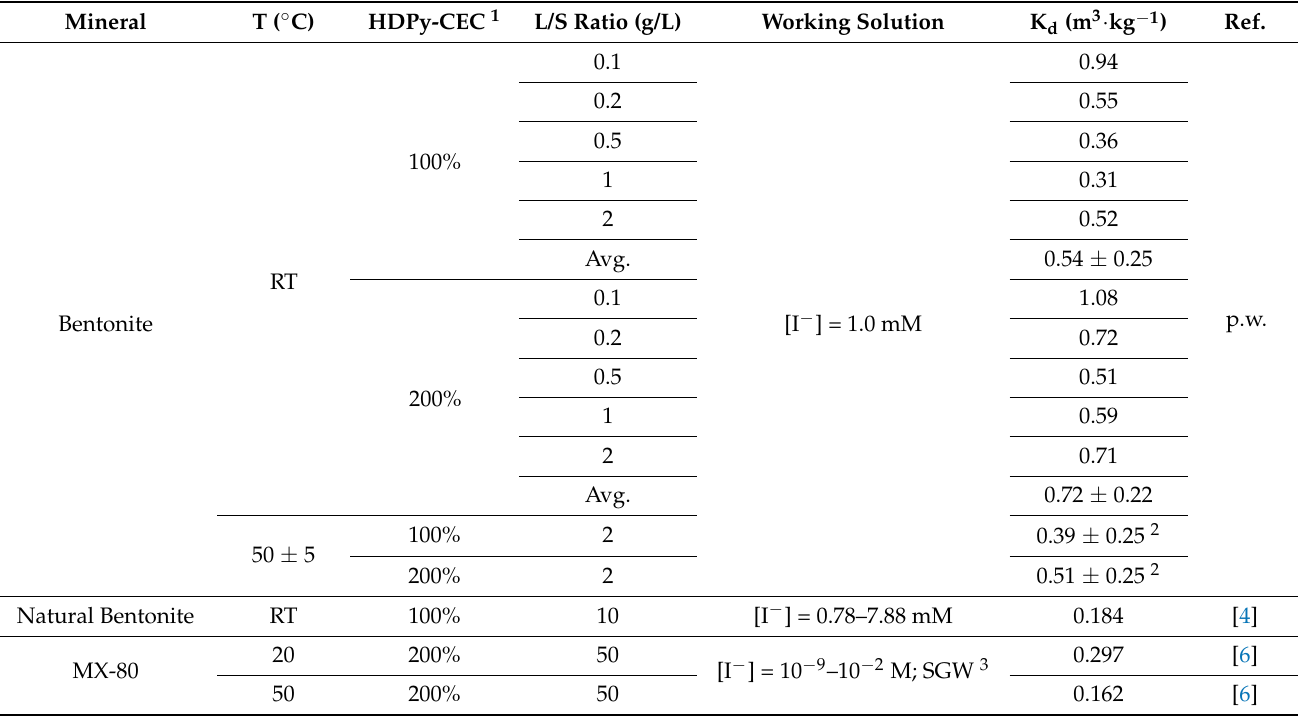
Table 1. The distribution coefficients of iodide obtained for HDPy-modified organo-bentonites at various